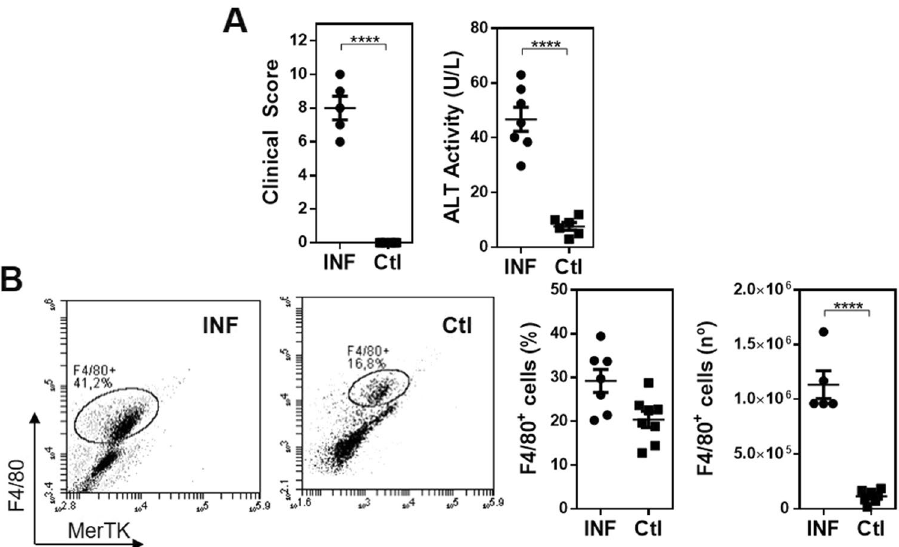
Figure 1. F. hepatica infected MGL2-DTR mice present an increase of F4/80 + cells in the peritoneal cavity. ( A ) Clinical score and ALT in serum after 3 wpi. MGL2-DTR mice were infected with 10 F. hepatica metacercariae (INF). Non infected mice injected with PBS were used as controls (Ctl). ( B ) Frequency and number of F4/80 + cells in the peritoneal cavity determined by flow cytometry. A representative figure of three independent experiments is shown (± SEM, indicated by error bars). Asterisks indicate statistically significant differences (**** p <